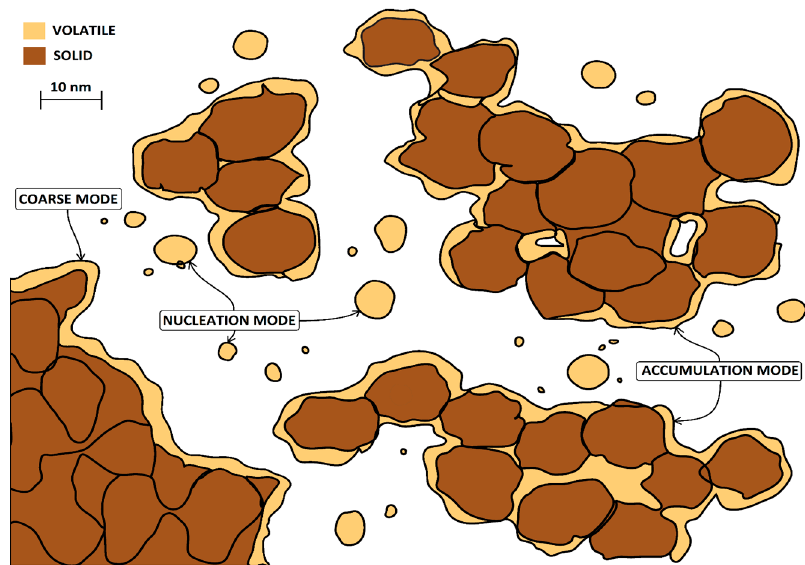
Figure 5. Typical particles depicted schematically: coarse mode, nucleation mode, and accumulation mode (adapted from ref